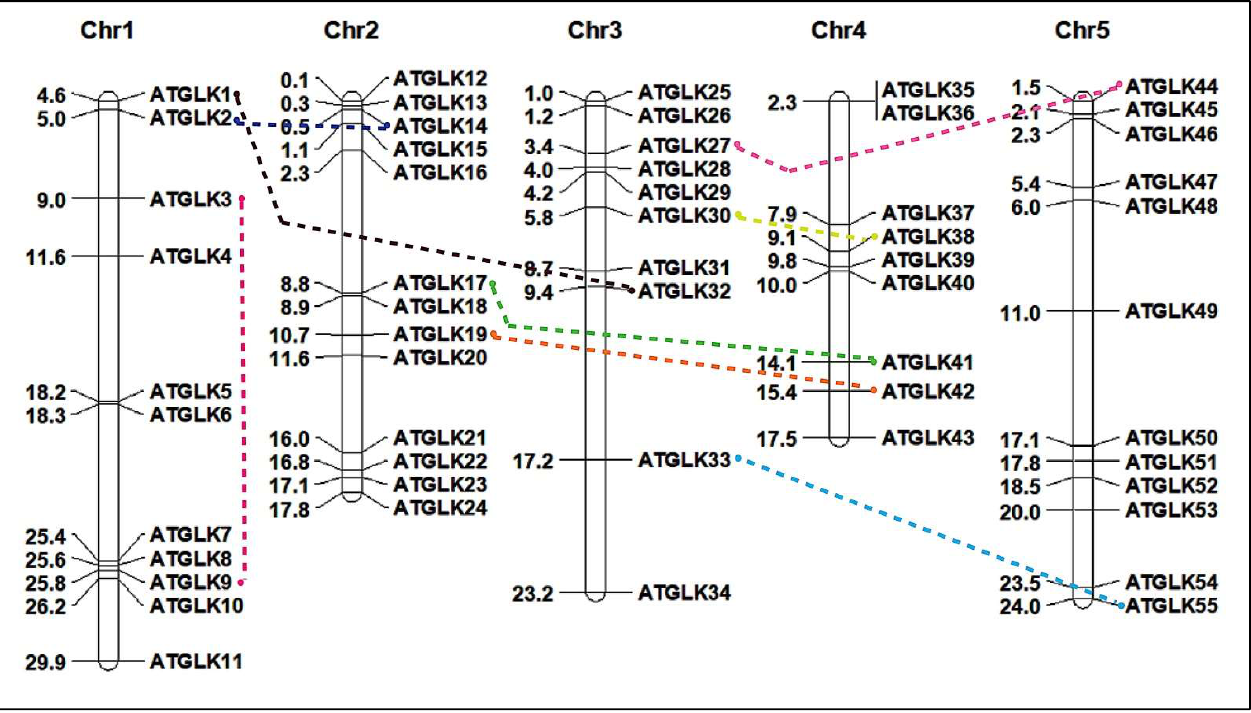
Figure 2. Distribution of 55 GLK genes on five chromosomes of Arabidopsis. The chromosome number (Chr1—Chr5) is indicated above each chromosome. The gene name and position (Mb) are indicated on different chromosomes. The positions of duplicated genes are linked with the dashed. Table 1. The Ka, Ks, and Ka/Ks ratios of AtGLK gene pairs.